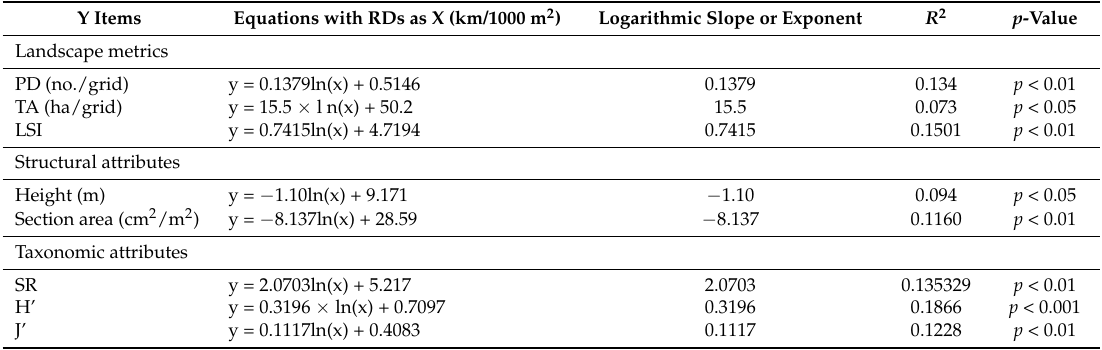
Table 3. The relationships between landscape metrics, structural-taxonomic attributes, and road densities (RDs) measured as road density